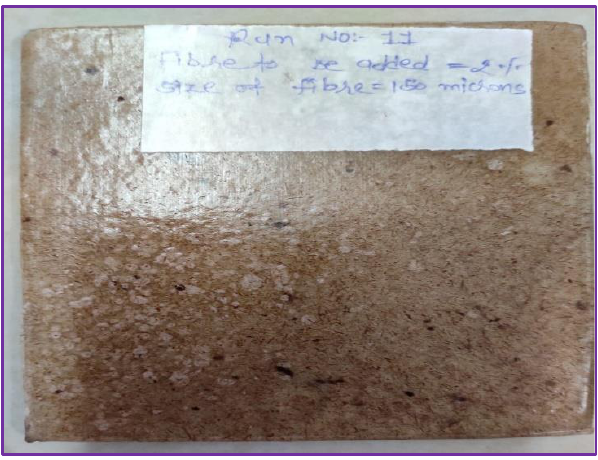
Figure 7. Specimen of composites.